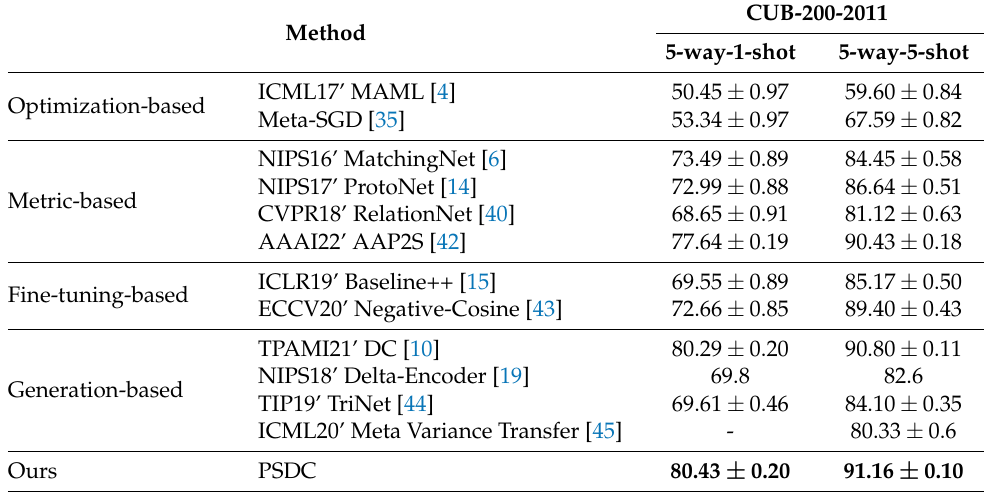
Table 2. 5-way-1-shot and 5-way-5-shot classification accuracy (%) on CUB-200-2011 with 95% confidence intervals.